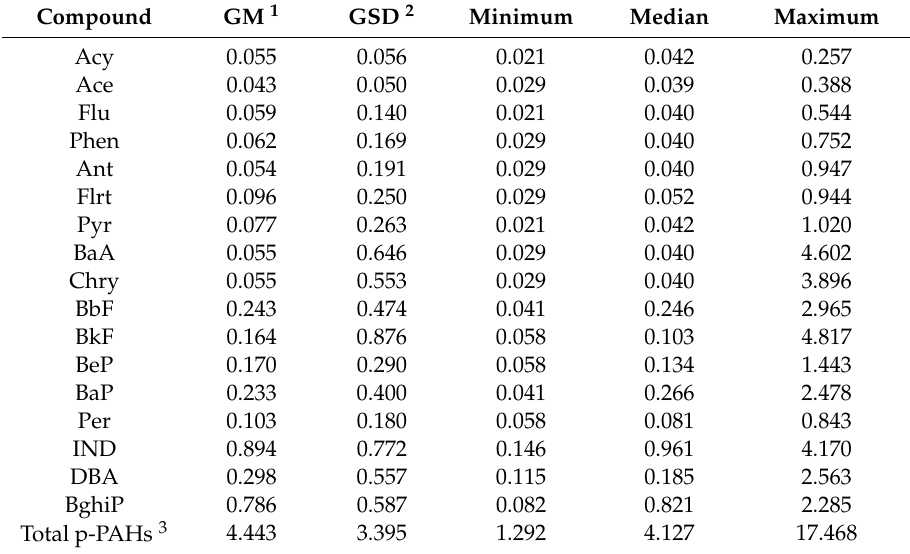
Table 2. Microenvironmental p-PAH exposures for elementary school children (ng / m 3